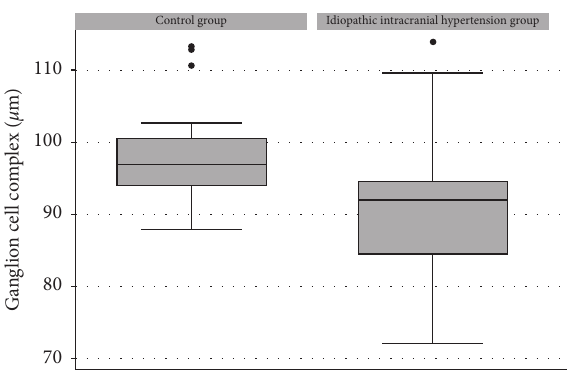
Figure 1: : Boxplots showing the distribution of the ganglion cell complex in the control and IIH groups. Box: median and interquartile range. Boxplot with whiskers with a maximum and minimum 1.5